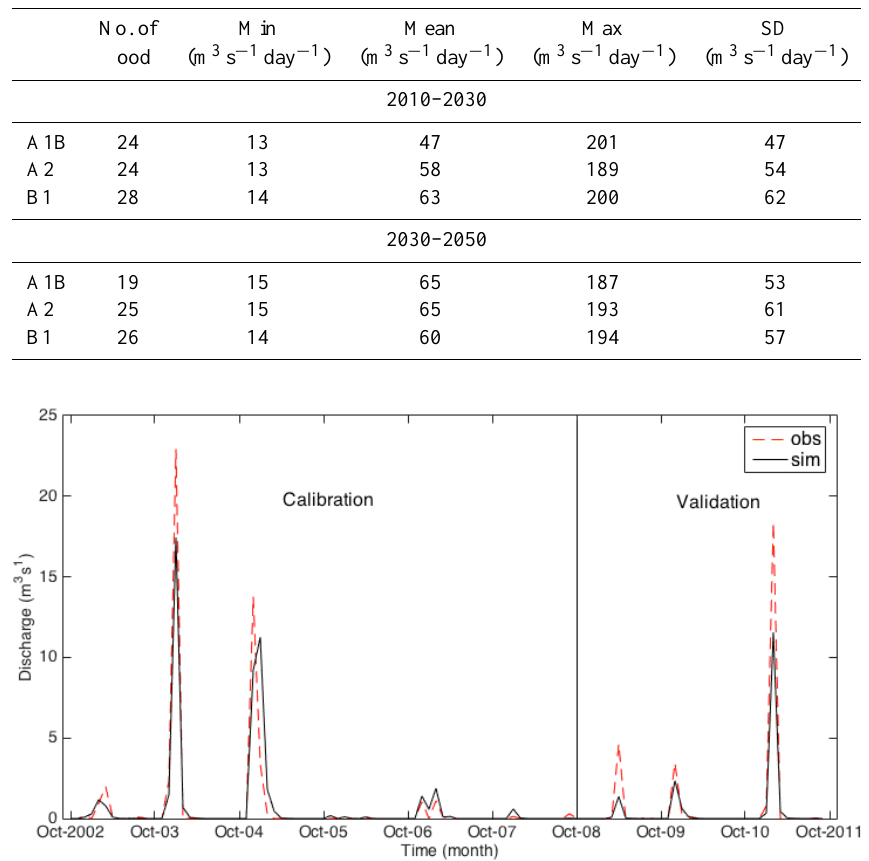
Figure 8. Observed and simulated monthly discharge (m 3 s − 1 month − 1 ) for the Baba Arab discharge station from 1 October 2002 through 30 September 2011.